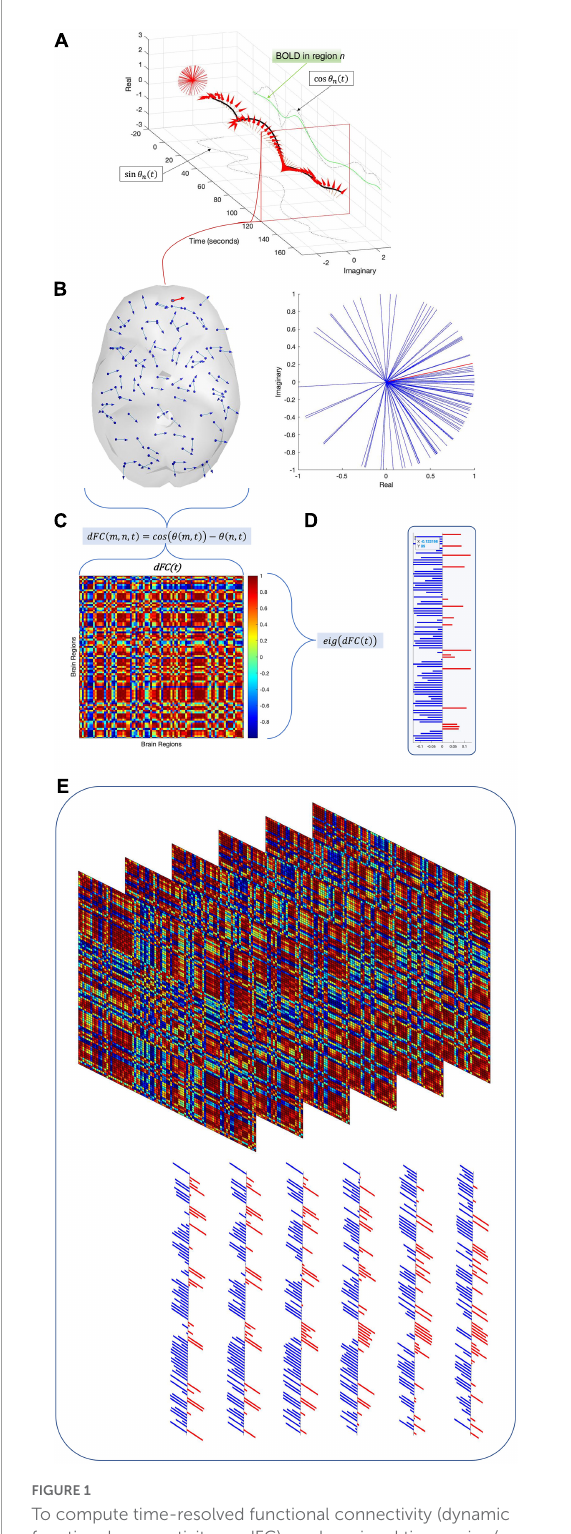
FIGURE1 To compute time-resolved functional connectivity (dynamic functional connectivity, or dFC), each regional time series (green trace) is converted into an analytic signal using the Hilbert transform. Euler’s formula converts this analytic signal into a